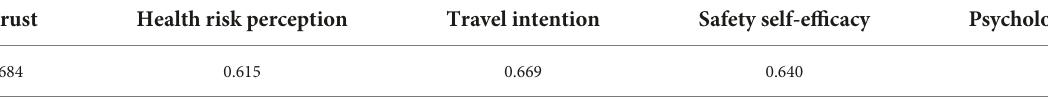
TABLE 5 Bootstrapping results for test of direct effects.